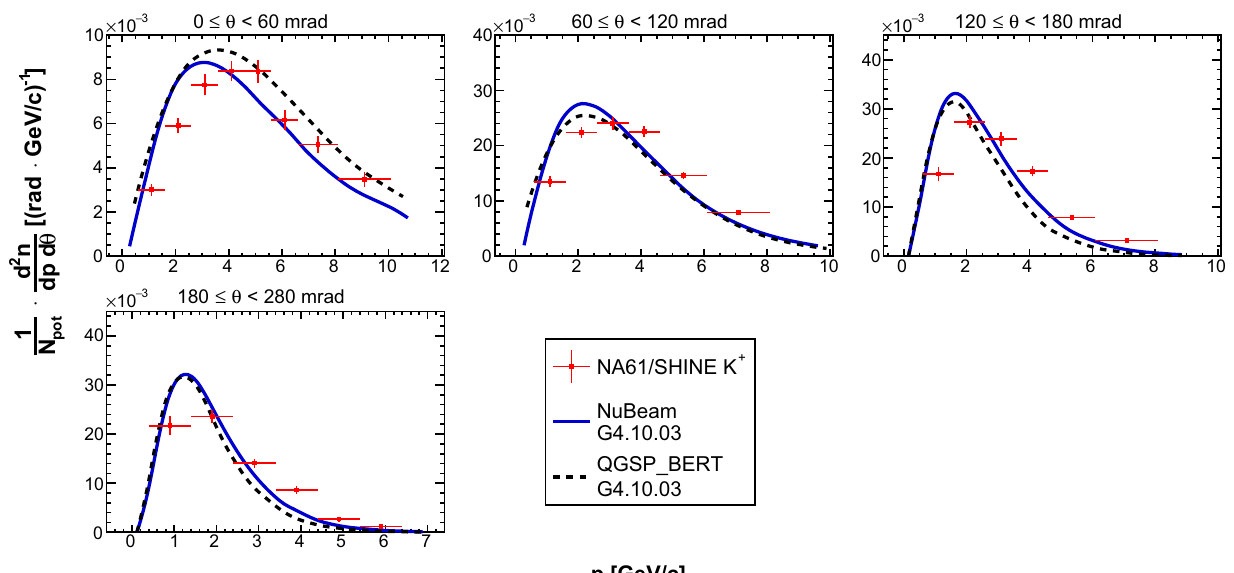
Fig. 37 Double differential yields of positively charged kaons for the third upstream longitudinal bin (36 ≤ z < 54 cm). Vertical bars represent the total uncertanties. Predictions from the NuBeam (solid